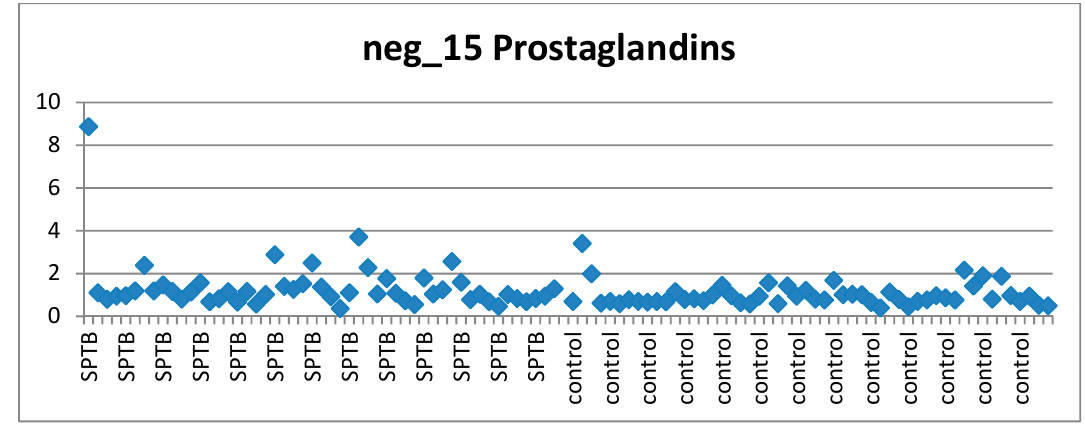
Figure 7. Distribution of feature neg_15 (Prostaglandin) across cases and controls.